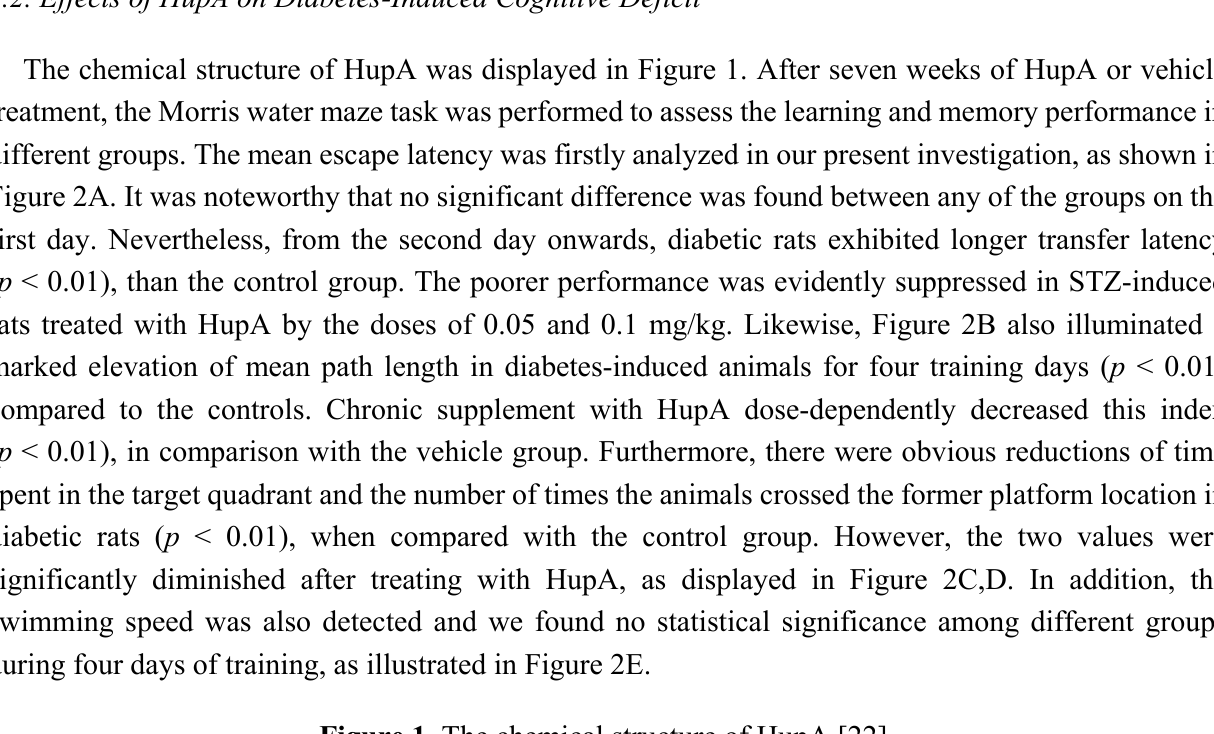
Figure 1. The chemical structure of HupA [22].